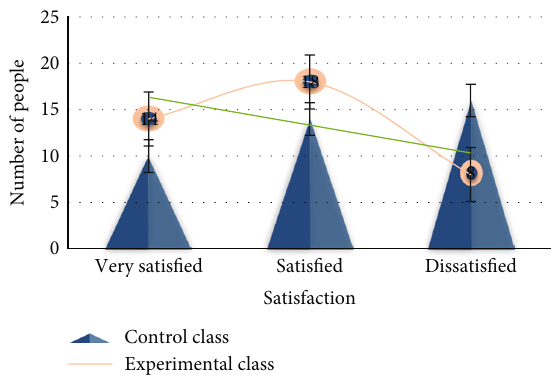
Figure 6: Satisfaction analysis of two